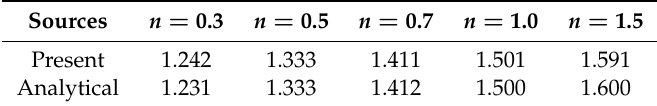
Table 1. The velocity peaks at Re =